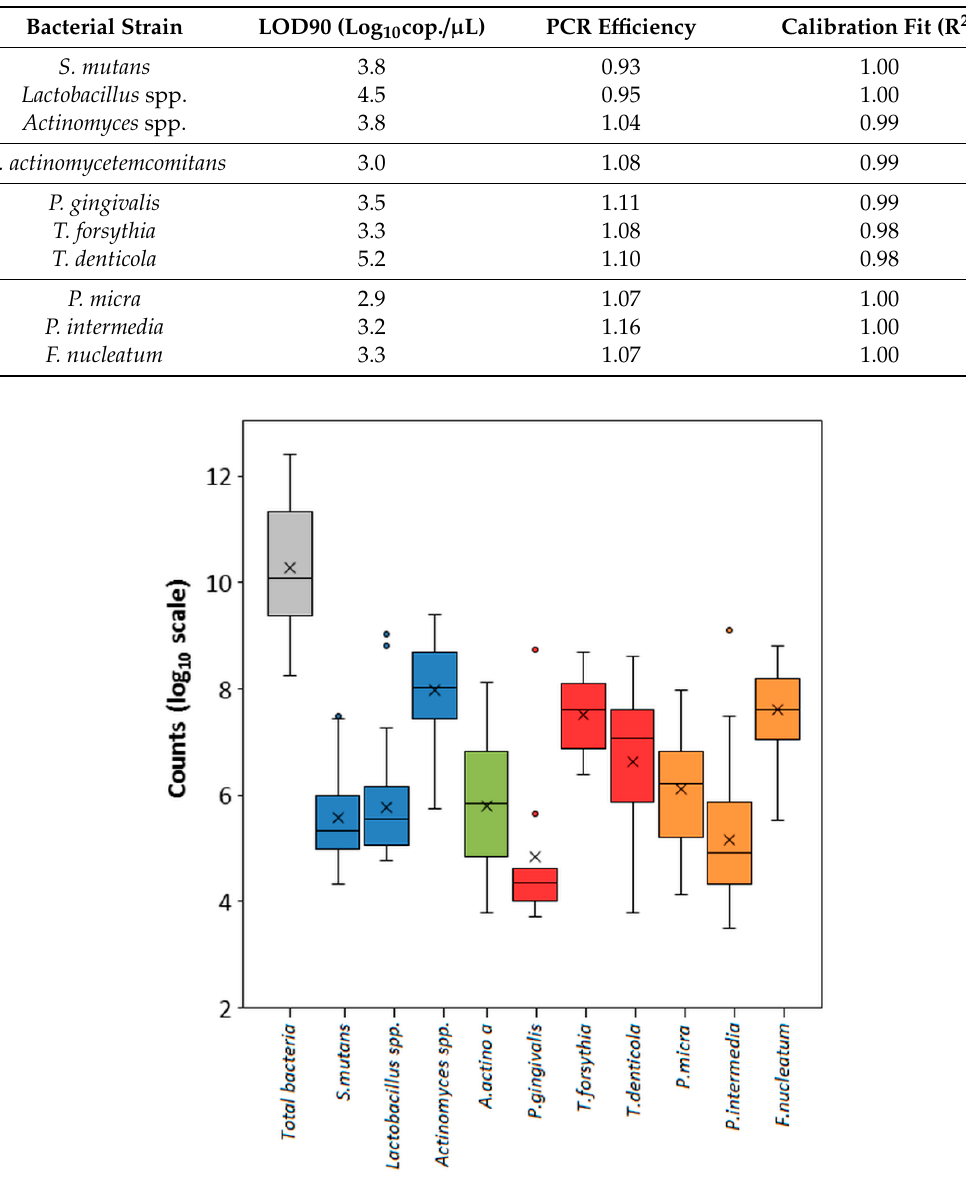
Table 3. The prevalence and percentage content of bacteria detected in the sample from the area of healthy teeth (HT) and affected teeth (AT).